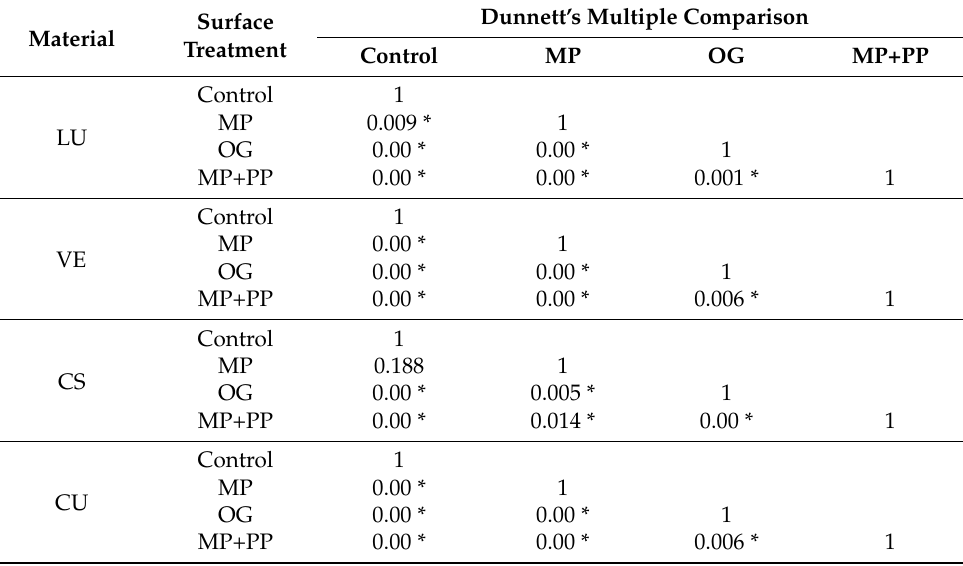
Figure 3. Overall mean Ra of the resin-modified ceramics irrespective of the surface treatment. Dashed line indicates the Ra threshold limit (0.2 µ m). Table 4. Pairwise comparison of the Ra of the surface-treated CAD/CAM